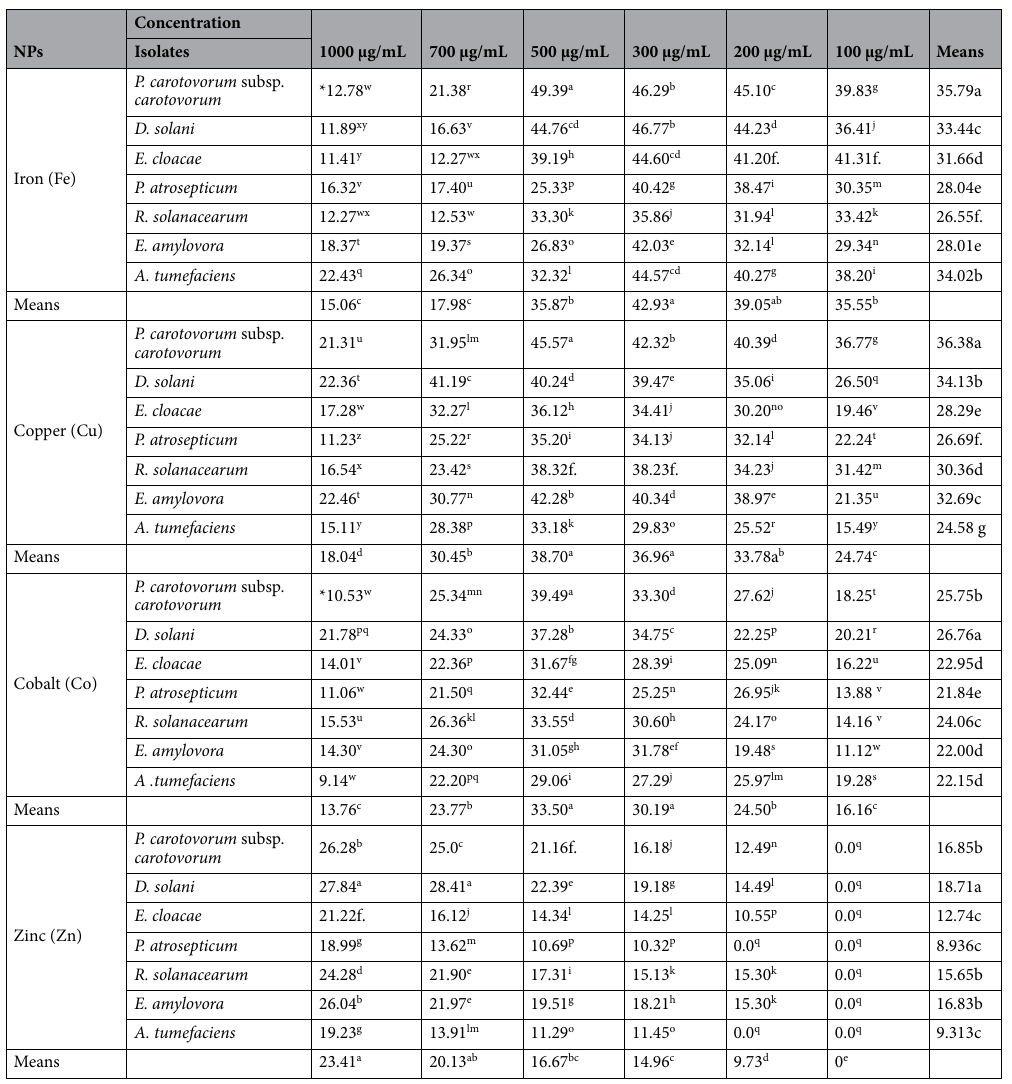
Table 4. Antibacterial activity of Fe, Cu, Co and Zn Nanoparticles (NPs) on the growth of some phytopathogenic bacteria. Statistically significant at p ≤ 0.05, Means with Common letters are not significant (i.e. Means with Different letters are significant), * Inhibition zone (IZ) diameter (mm).